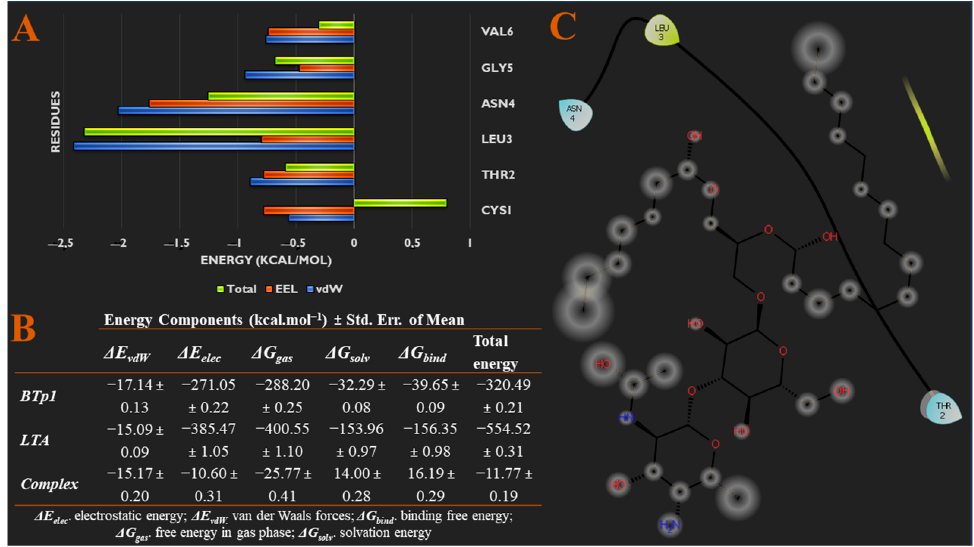
Figure 4. ( A ) Per-residue energy decomposition analysis showing specific energy contributions of each amino acid residue of BTp1 that contributes to binding. ( B ) Different energy contributions of each component of the system via MM/GBSA thermodynamics. ( C ) Binding interaction diagram of BTp1 to residues of TLR2.